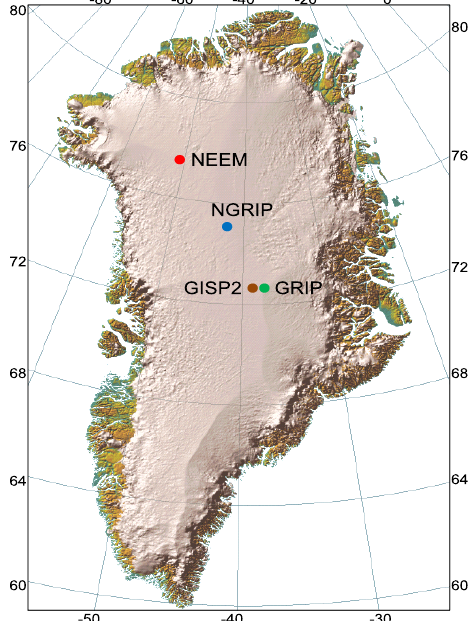
Fig. 1. Greenland map (Simon Ekholm, Danish cadastre) with the ice core sites: NEEM (red), NGRIP (blue), GISP2 (brown) and GRIP (green). Top and bottom numbers indicate longitude ( ◦ W), left and right numbers indicate latitude ( ◦ N).